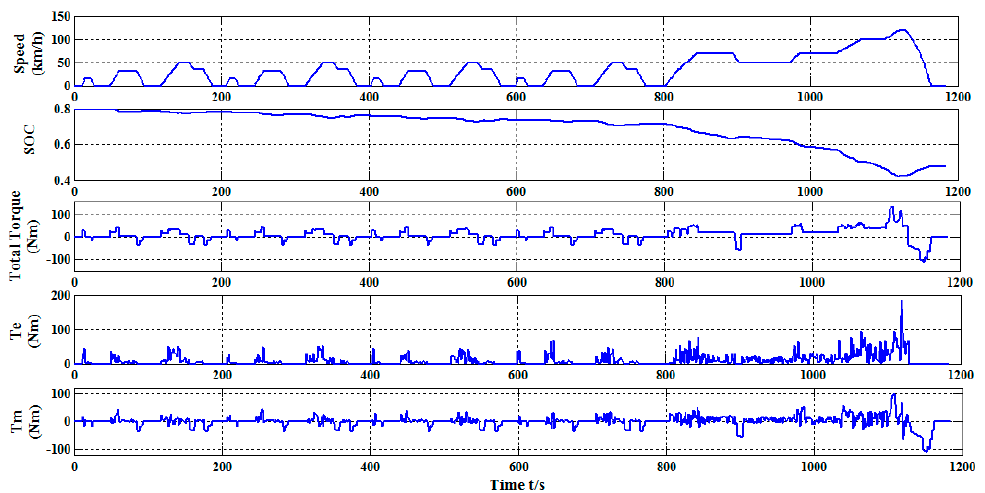
Figure 10. Simulation results of the trained EMS under NEDC.